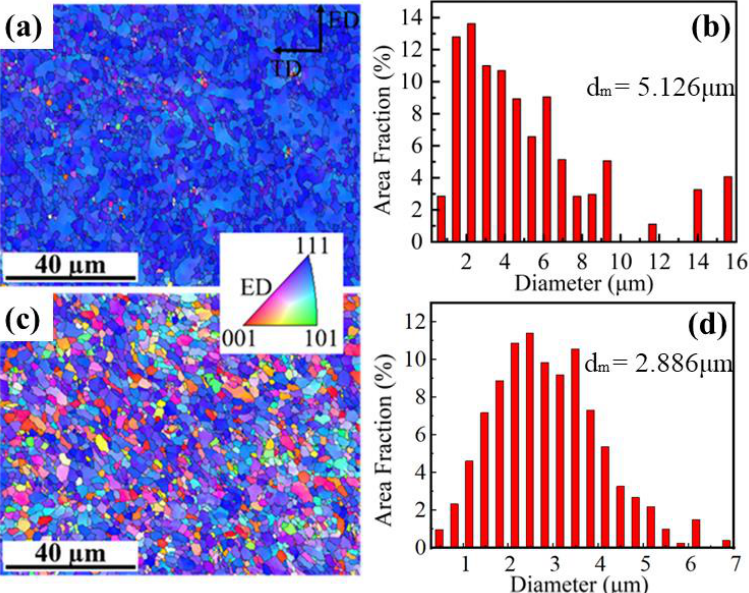
Figure 10. EBSD mapping and grain sizes for the GNP/Al composite extruded by the porthole die: ( a , b ) welding zone; ( c , d ) matrix zone.